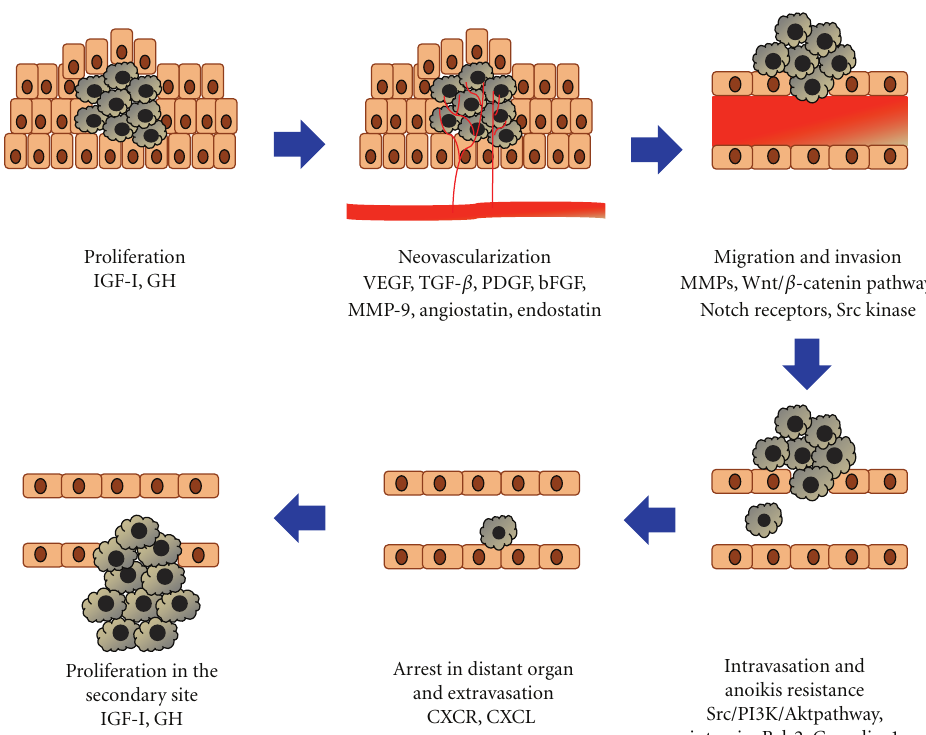
Figure 1: The main steps of the tumor metastatic process. Tumor cells proliferate at the primary site and neovascularization is induced by tumor environment such as hypoxia. In turn, they migrate and invade into the bloodstream. These tumor cells in the circulation need to survive against anoikis to arrest in a distant organ. Metastatic colonization at the secondary site involves the interactions between tumor cells and the